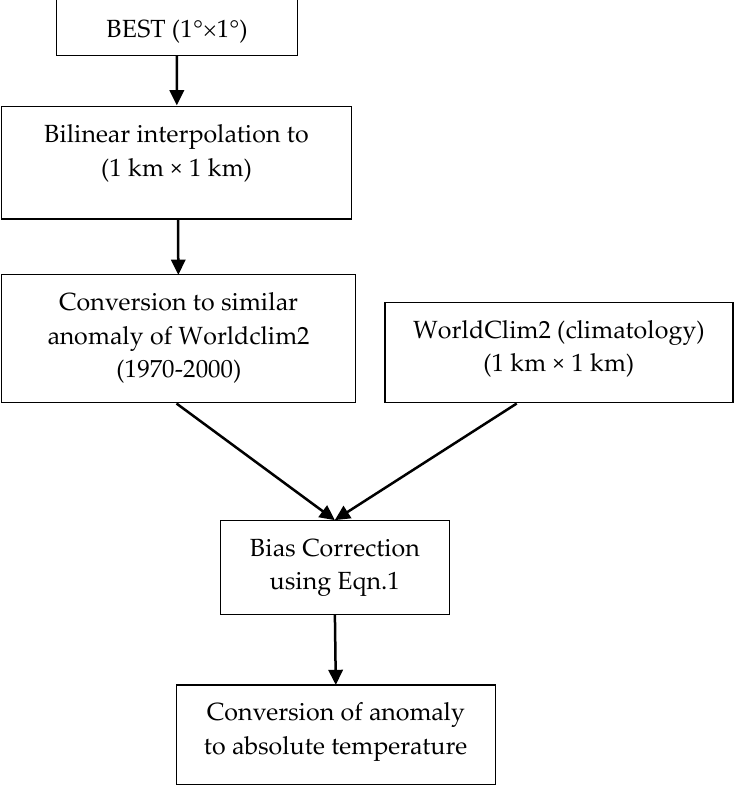
Figure 2. Flowchart showing steps followed to downscale temperature.